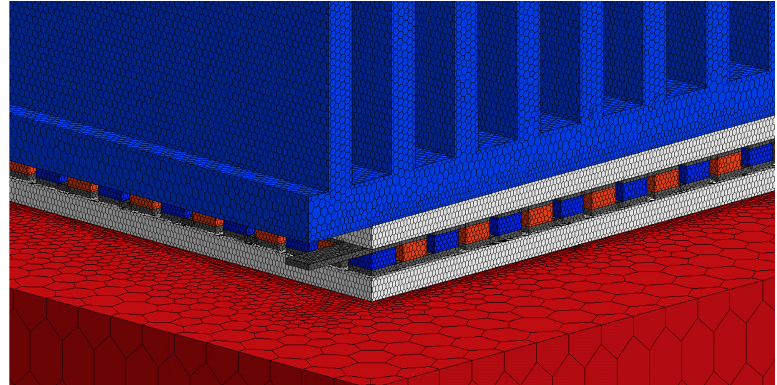
Figure 8. Mesh grid of the TEG